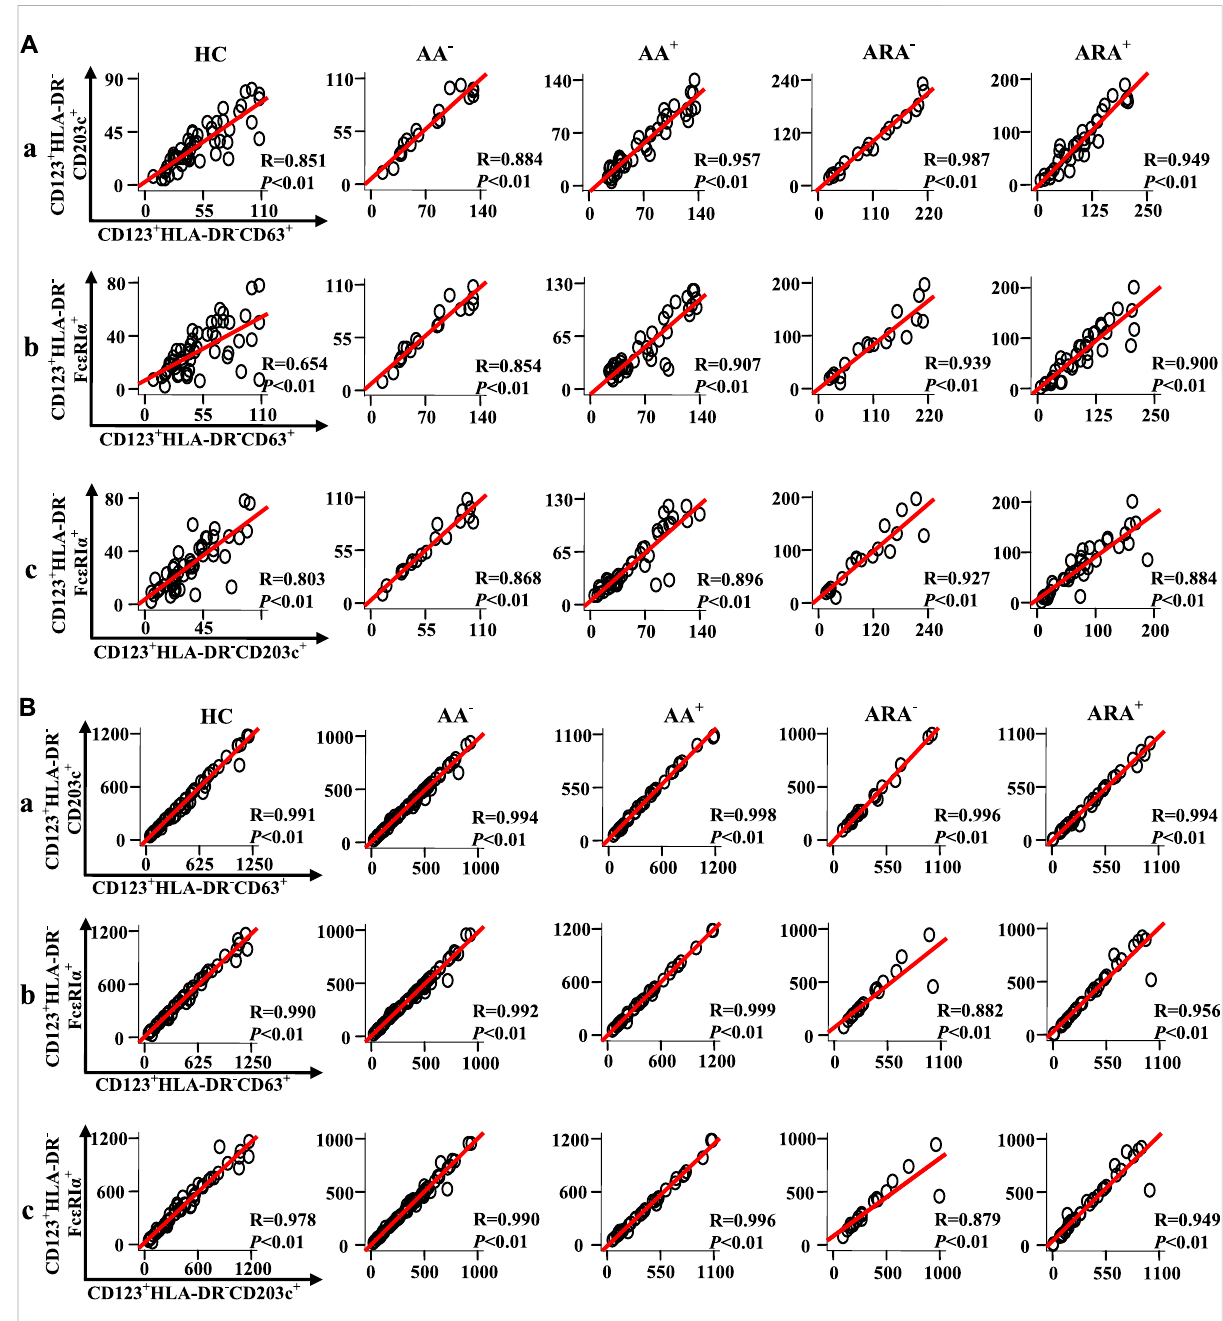
FIGURE 6 Scatter plots, linear regression lines, and coef fi cients between the variables of patients with allergic rhinitis (AR) and HC subjects. Correlations between numbers of CD63 +, CD203c +, and Fc ε RI α + cells in CD123+HLA-DR − granulocytes (A) and PBMC (B) of skin prick test (SPT)-negative AA (AA − ),SPT-positiveAA(AA+),SPT-negativeAAcombined withallergicrhinitis (ARA − ),SPT-positiveAA combined withallergicrhinitis (ARA+)patients and HC subjects were analyzed using Pearson ’ s correlation test. Indicated cells were counted in 100,000 leukocytes. Correlation coef fi cient rangeswerede fi nedasfollows: R < 0.3asaweakcorrelation,0.3 ≤ R ≤ 0.7asamoderatecorrelation, and R > 0.7asastrongcorrelation. p < 0.05was taken as statistically signi fi